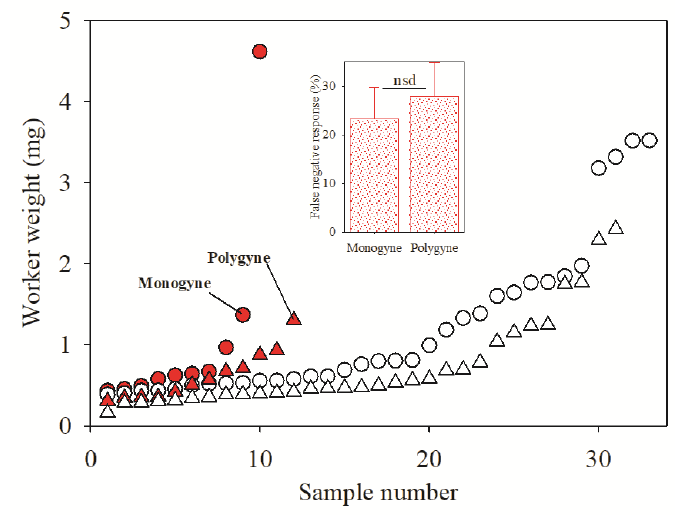
Figure 2. Influence of worker ant weight on the response of the InvictDetect TM Immunostrip ® . Each symbol represents the response from an individual worker ant from a monogyne (n = 43) or polygyne (n = 43) colony. Open symbols represent positive InvictDetect TM responses, and red symbols represent false negative responses; triangles = polygyne, and circles = monogyne. Inset: Mean (± standard error) false negative responses from monogyne and polygyne individual workers. NSD = no significant difference by Student’s t-test (t = 0.49; df = 84; p = 0.63). The mean weight of the polygyne workers that produced a false negative (0.61 ± 0.30 mg) was not significantly different (t = 1.15; df = 20; p = 0.28) from the mean weight of the monogyne workers that produced a false negative response (1.09 ± 1.27 mg) (Figure 3). Furthermore, the mean weight of the individual worker ants that produced a false negative response was not significantly different from the weight of the individual ants that produced a positive InvictDetect TM response for the monogyne (t = −0.34; df = 41; p = 0.74) and polygyne (t = −0.98; df = 41; p = 0.34) social forms (Figure